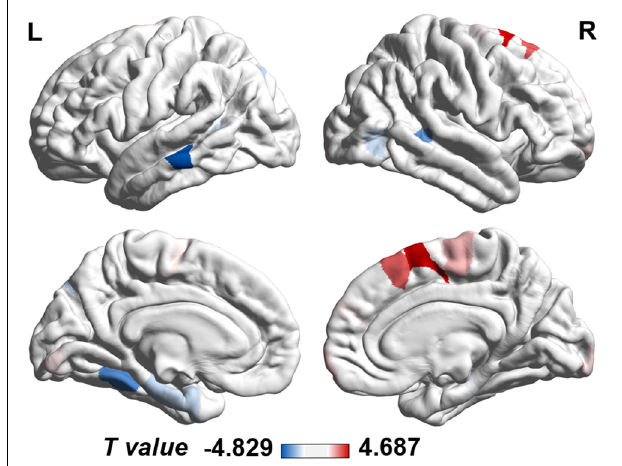
FIGURE 1 | Case-control differences in regional morphometric similarity ( P < 0.05, FDR corrected). Regions in blue indicate significantly decreased morphometric similarity in AD, whereas regions in red indicate significantly increased morphometric similarity in AD. FDR, false discovery rate; L, left; R,